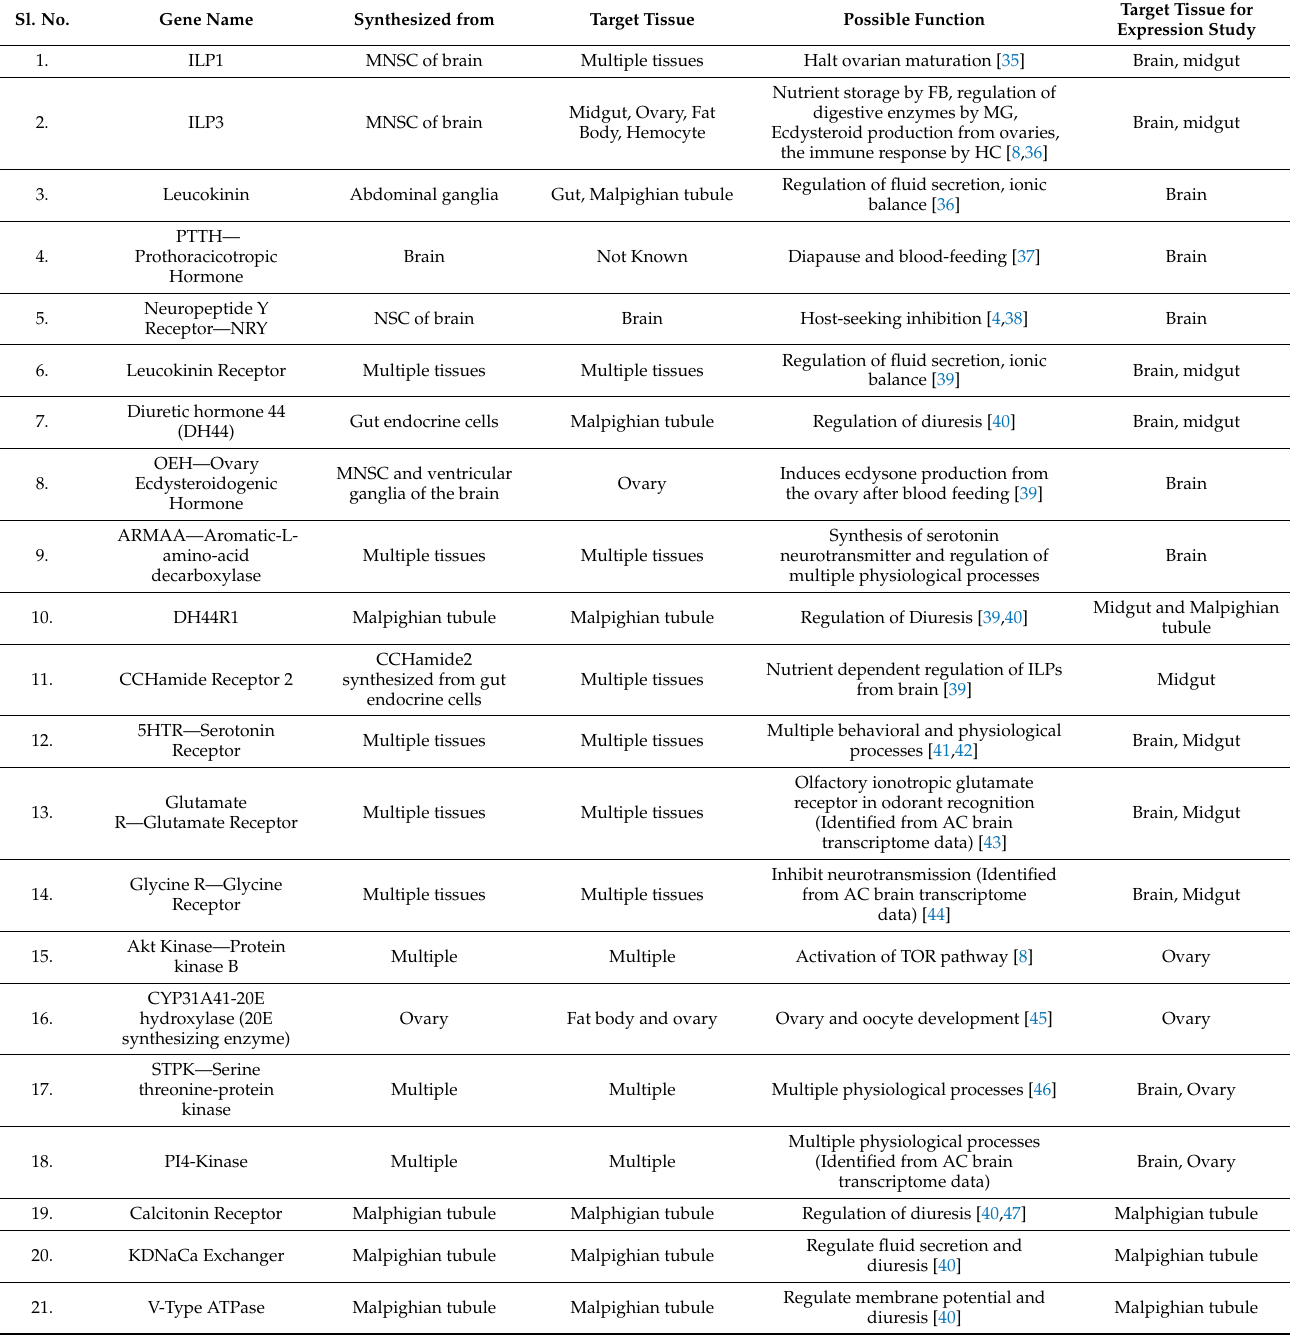
Table 1. Details of the selected transcripts used to understand inter-organ communication during metabolic switch